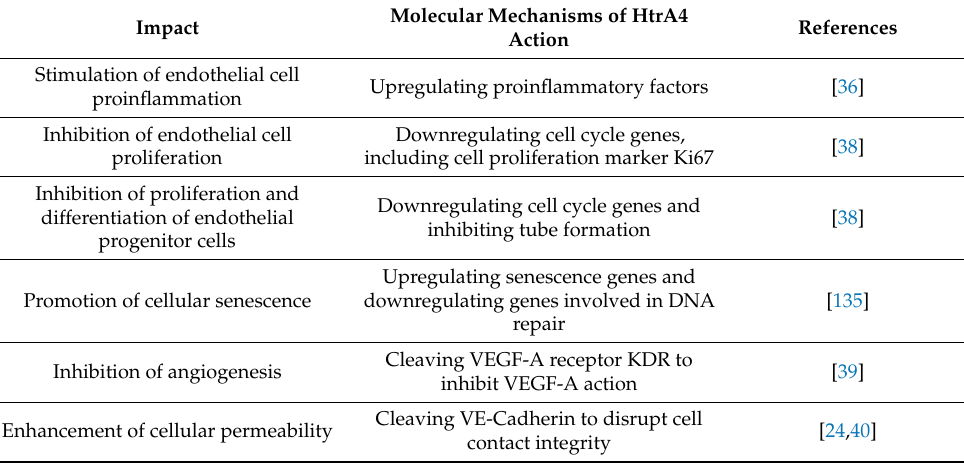
Table 6. Potential impact of human HtrA4 protein on endothelial cells in